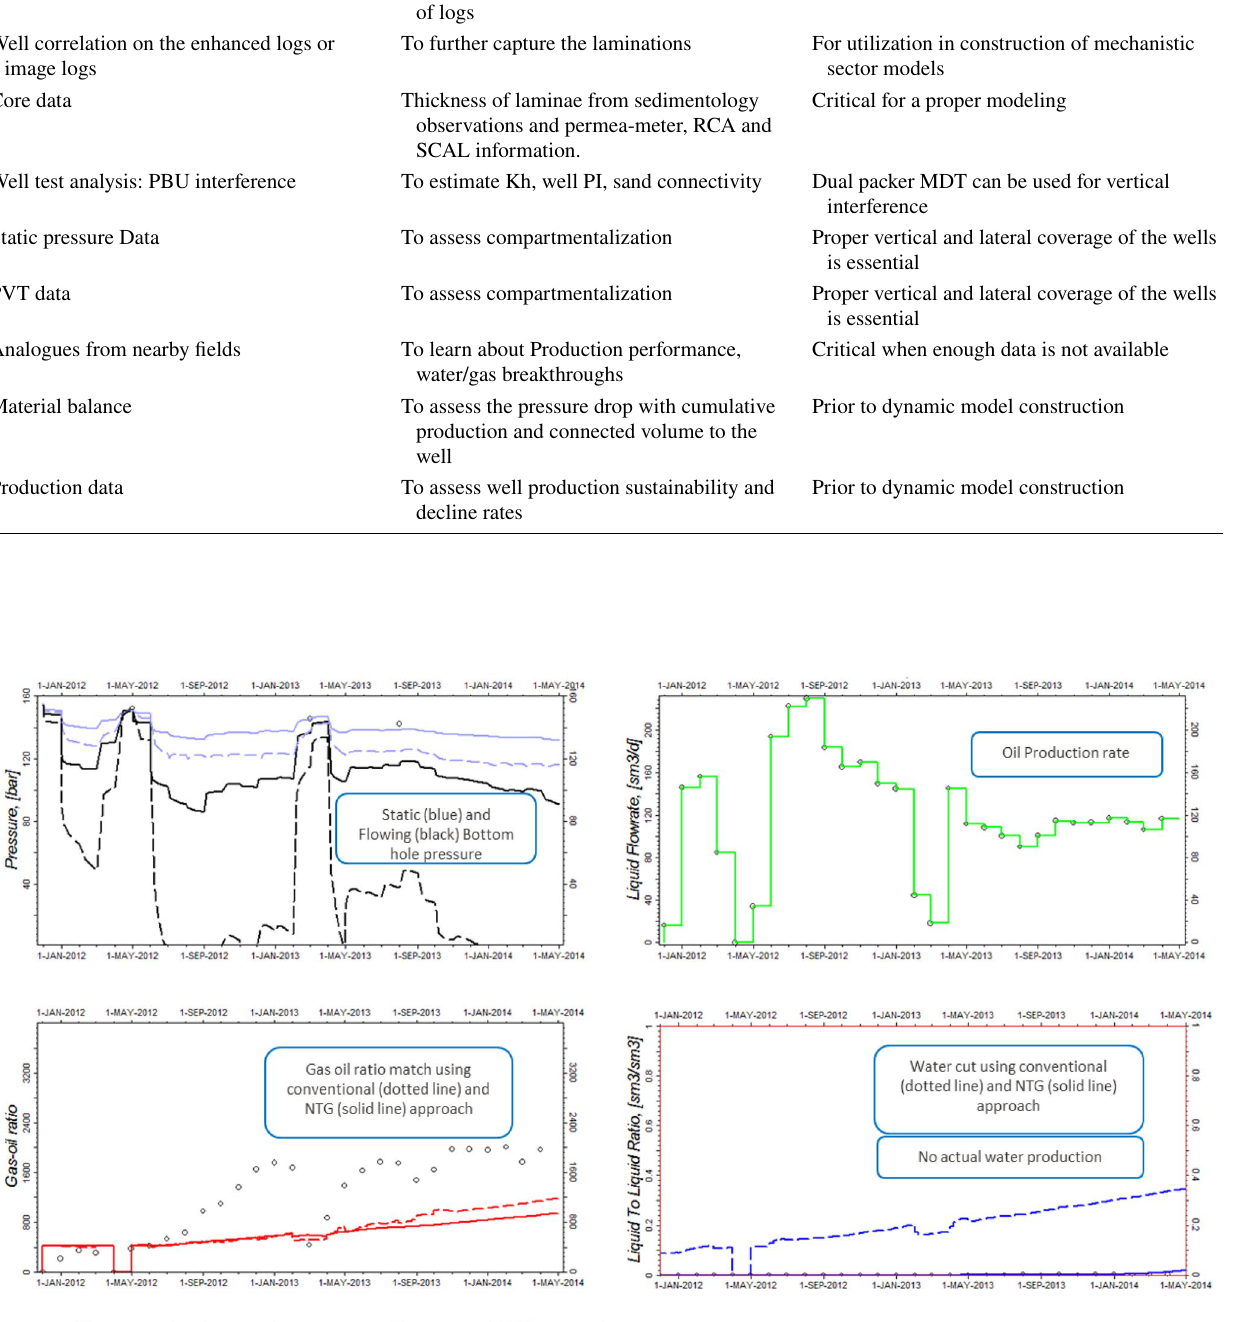
tom right). The small hollow circles represent the measured data. The static bottom-hole pressure and water-cut profiles are matched using the proposed NTG approach whereas the conventional approach fails completely to reproduce the actual field